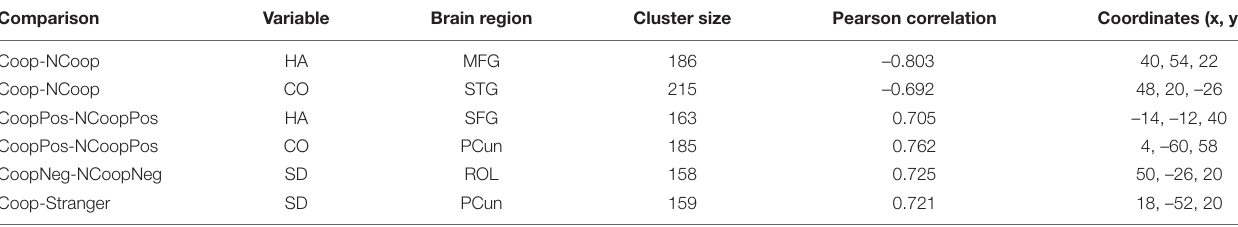
TABLE 2 | Brain regions whose dissimilarity between stimuli pairs correlated with temperament or character dimensions. Comparison Variable Brain